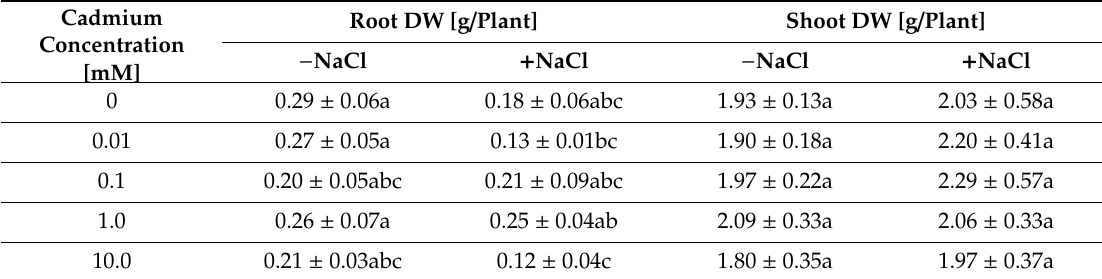
Table 1. Weight of roots and shoots of soil-grown NaCl-untreated ( − NaCl) and salt-stressed ( +